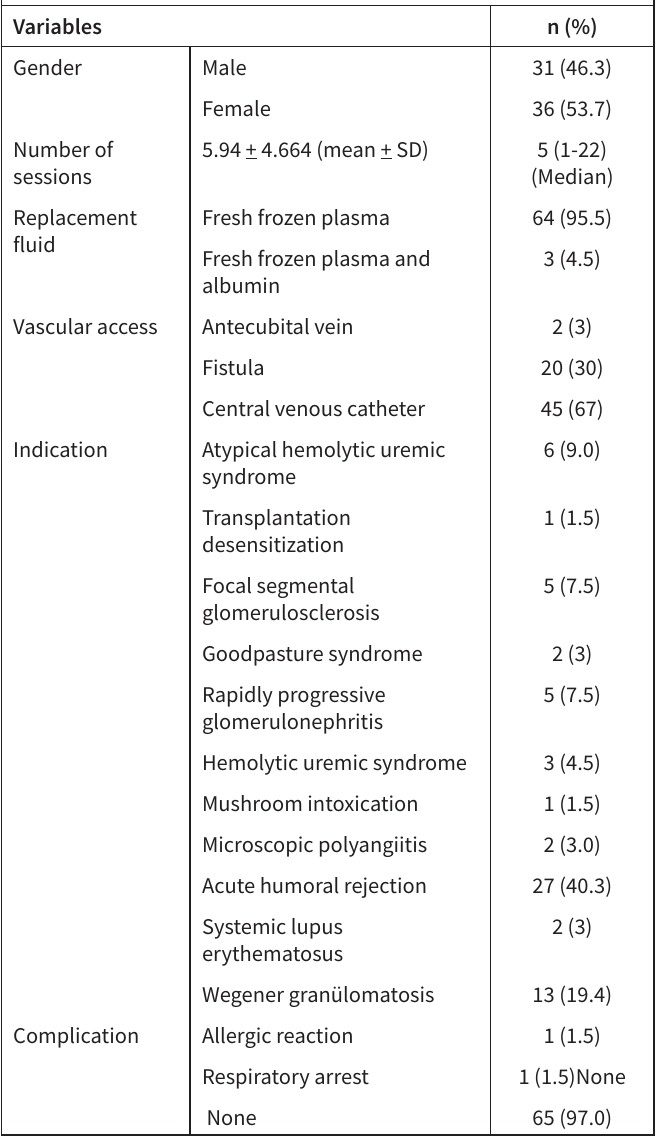
Table 2. Apheresis Indications and Findings